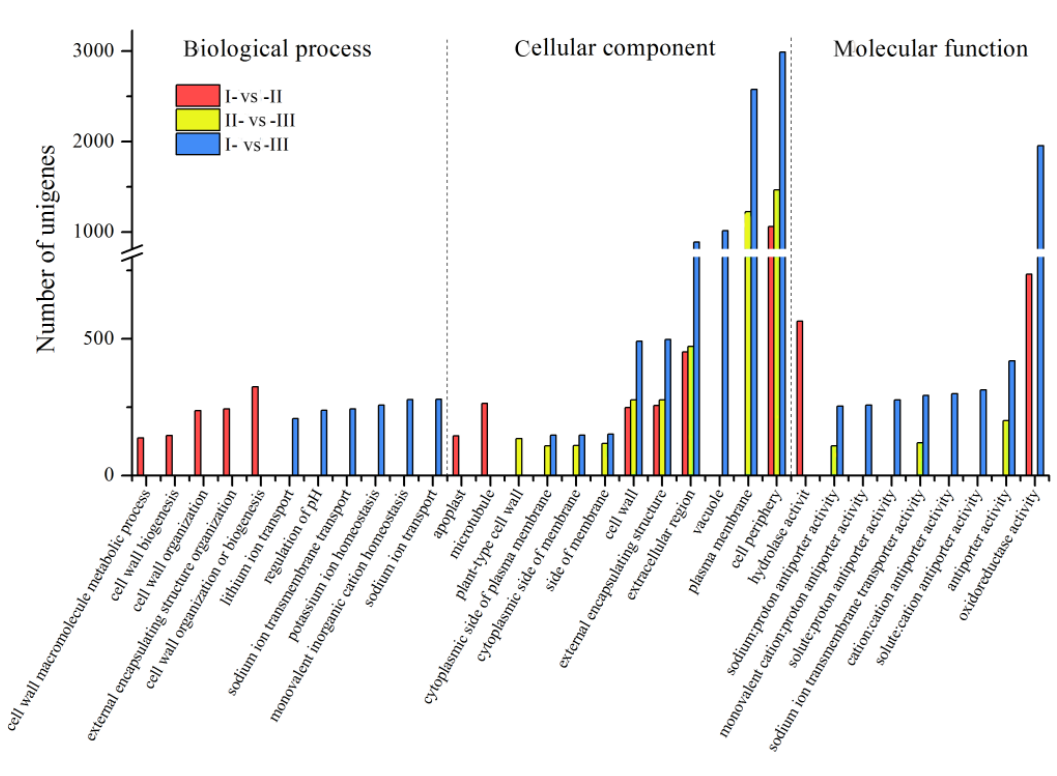
Figure 4. Comparison of Gene Ontology (GO) annotation categories of the Chinese chestnut kernel at three developmental stages.